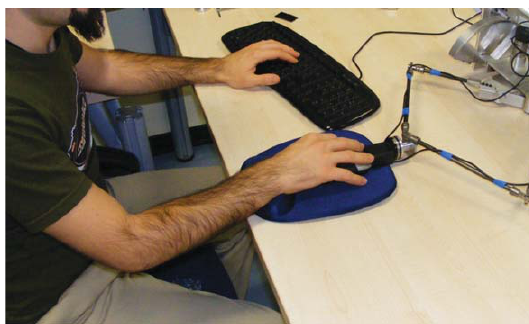
Fig. 6. Subject interacting with the mouse attached to the assistive haptic